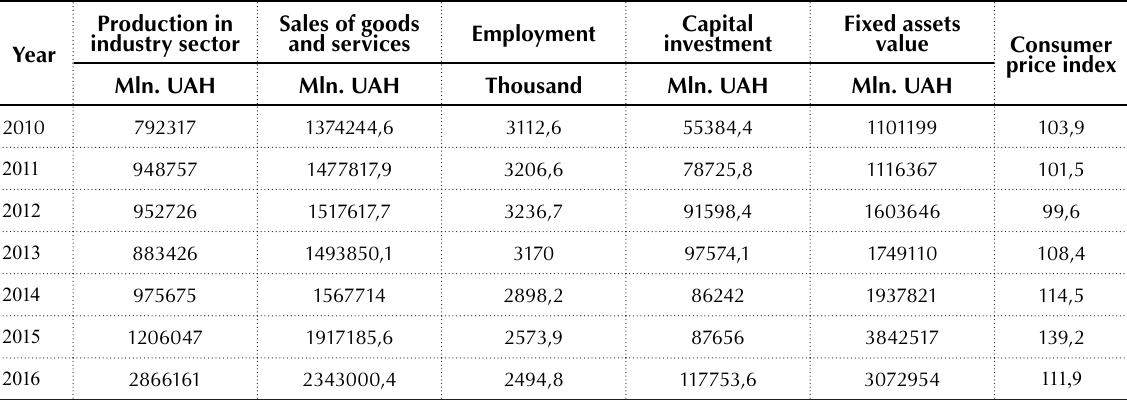
Table 2. Main indicators of the industry development in